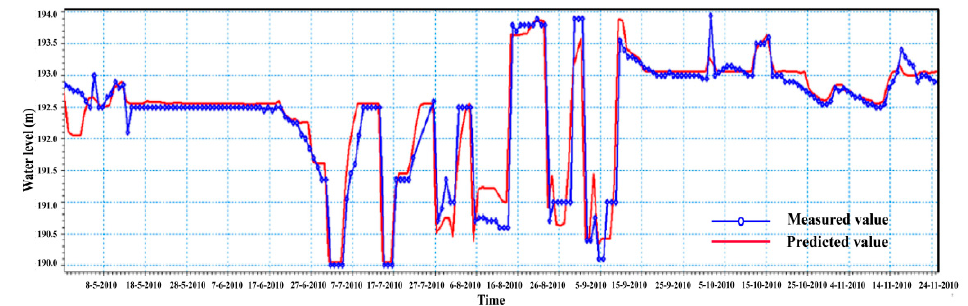
Figure 4. Simulated result of the water level at Cross Section C.